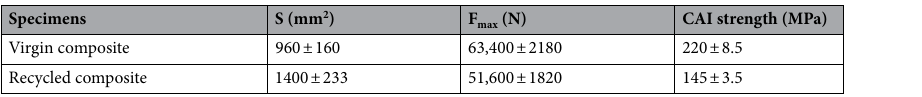
Table 2. Delaminated area, maximum force and CAI values of the virgin and recycled composites